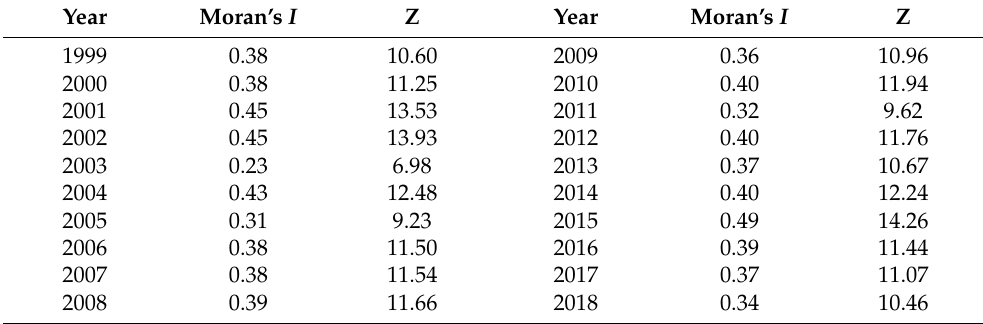
Table 9. Global Moran’s I index and Z value of the coupling system in 110 cities from 1999 to 2018.